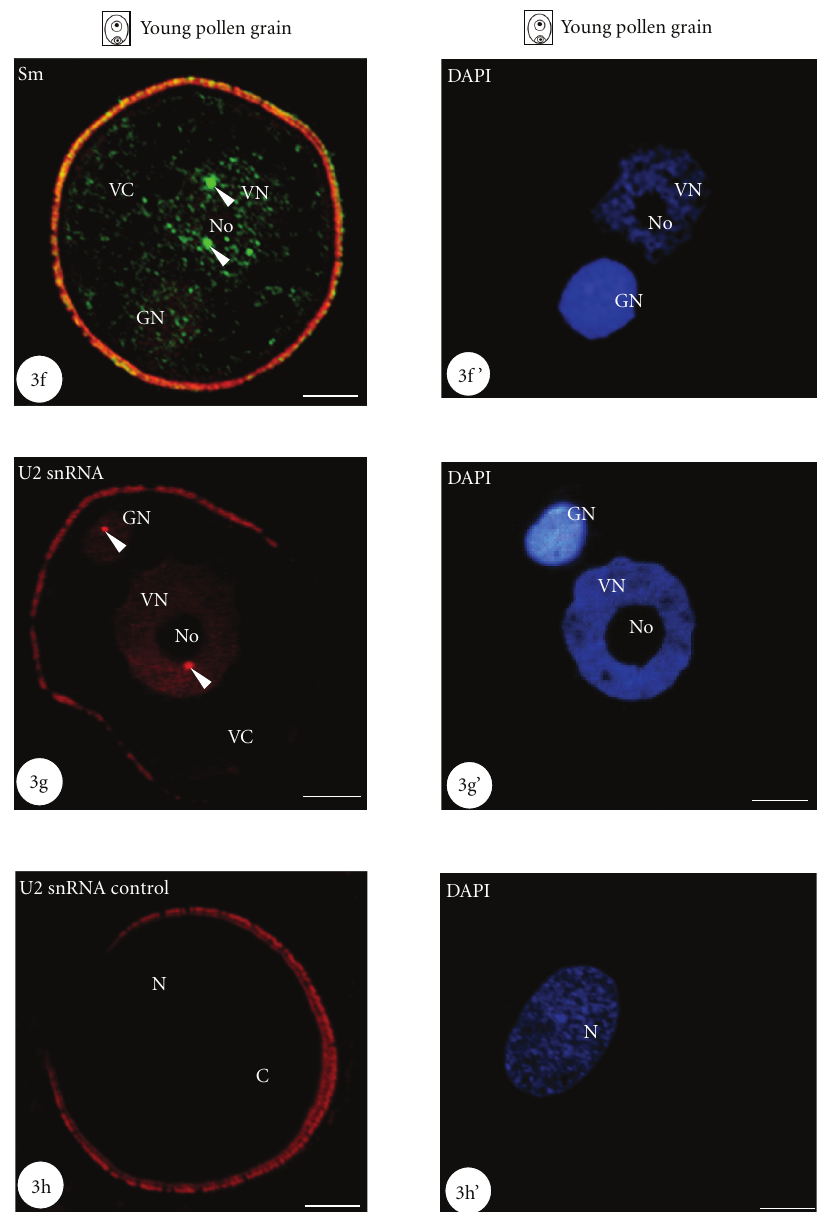
Figure 3: Concentration of snRNP-indicating molecules in nuclear bodies of microspore and young pollen cells showed using immunofluorescence techniques (N-nucleus, No-nucleolus, VN-vegetative nucleus, VC-vegetative cytoplasm, GN-generative nucleus, GC- generative cytoplasm). Figures 3’–3g’. DAPI staining of given microspores and pollen grains are shown. Bars-10 μ m. Figure 3. Polarized microspore is shown. Immunofluorescence localization of TMG snRNA indicating its high accumulation in the nuclear body (arrowhead) adjacent to the nucleolus is shown. Figure 3a. Nuclear body containing high levels of Sm proteins (arrowhead) can be seen in the microspore nucleoplasm. Figures 3b and 3b’ show the magnification of the area marked with the dashed line on Figures 3a and 3a’. No DNA labelling can be observed in the area of the nuclear body (arrowheads). Figure 3c. High concentration of U2 snRNA is visible in two nuclear bodies (arrowheads) adjacent to the nucleolus in microspore nucleus. Figure 3d. Pollen grain just after microspore mitosis is shown. Nuclear body containing high levels of TMG snRNA is indicated in the vegetative nucleoplasm (arrowhead). Figures 3e and 3e’ show the magnification of the area marked with the dashed line on Figures 3d and 3d’. The lack of DNA can be observed in the nuclear body area (arrowheads). Figure 3f. Young pollen grain is shown. Two Sm-rich nuclear bodies are present in the vegetative nucleus (arrowheads). Figure 3g. In the vegetative and generative nucleus of young pollen grain one nuclear body, containing U2 snRNA is indicated (arrowheads). Figure 3h. Control reaction of fluorescence in situ hybridization performed with the U2 snRNA sense probe (N-nucleus, C-cytoplasm) is shown. No labeling can be seen in the nucleus of polarized microspore. Figure 3h’. DAPI staining of microspore is shown on Figure